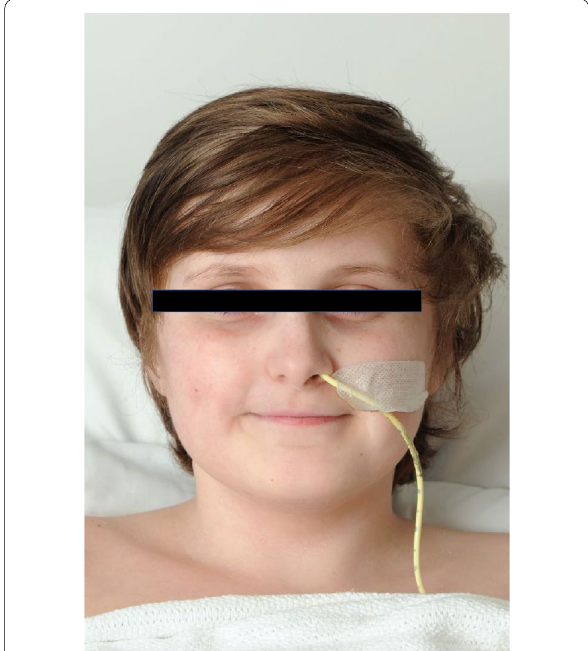
Fig. 4 Characteristic facial features of EDS type IV (prominent eyes, thin pointed nose, narrow